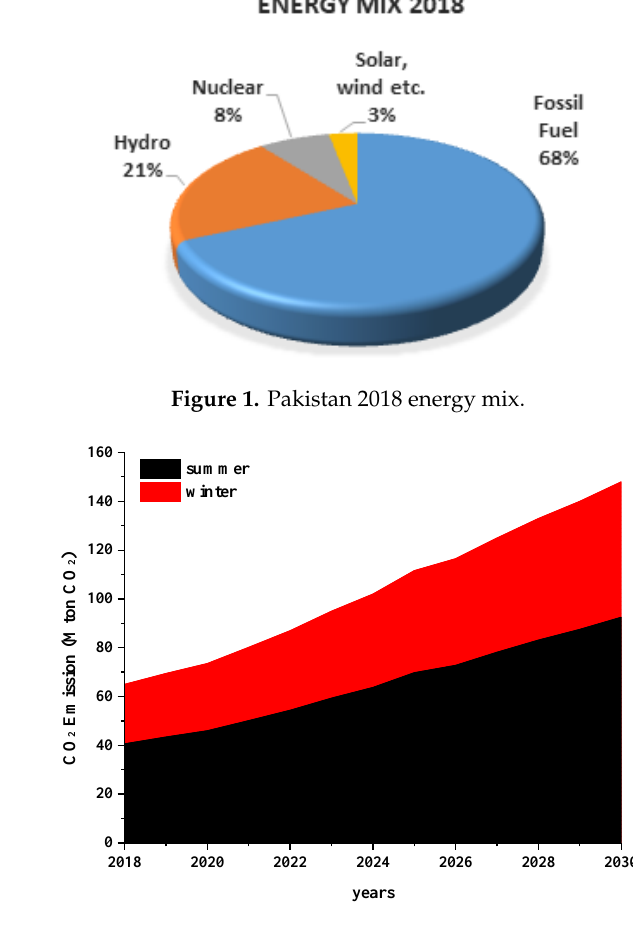
Figure 2. CO 2 emissions projection of Pakistan.